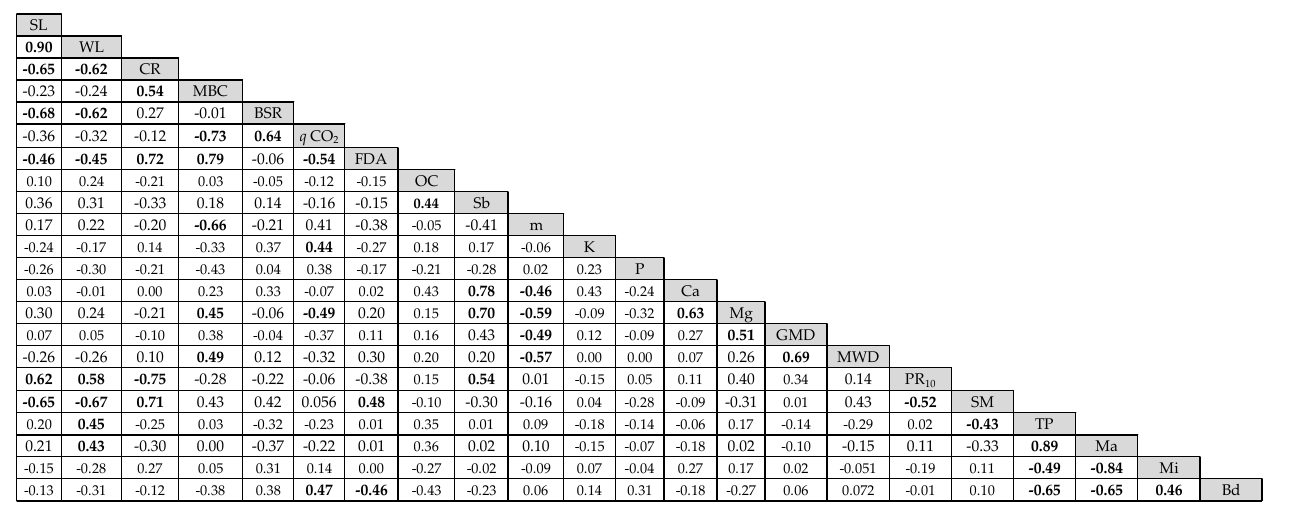
Figure 4. Pearson correlation matrix for variables sampled in crop rows. SL = soil losses, WL = water losses, CR = cover rate, MBC = microbial biomass carbon, BSR = basal soil respiration, q CO 2 = metabolic quotient, FDA = fluorescein diacetate hydrolysis, OC = soil organic carbon, Sb = sum of bases, m = aluminum saturation of soil, K = potassium, P = phosphorus, Ca = calcium, Mg = magnesium, MWD = mean weight diameter, GMD = geometric mean diameter, PR 10 = soil resistance to root penetration at 10 cm depth, SM = soil moisture in situ, TP = total porosity, Ma = macroporosity, Mi = microporosity, and Bd = bulk density. Values in bold print: significant at 5%.